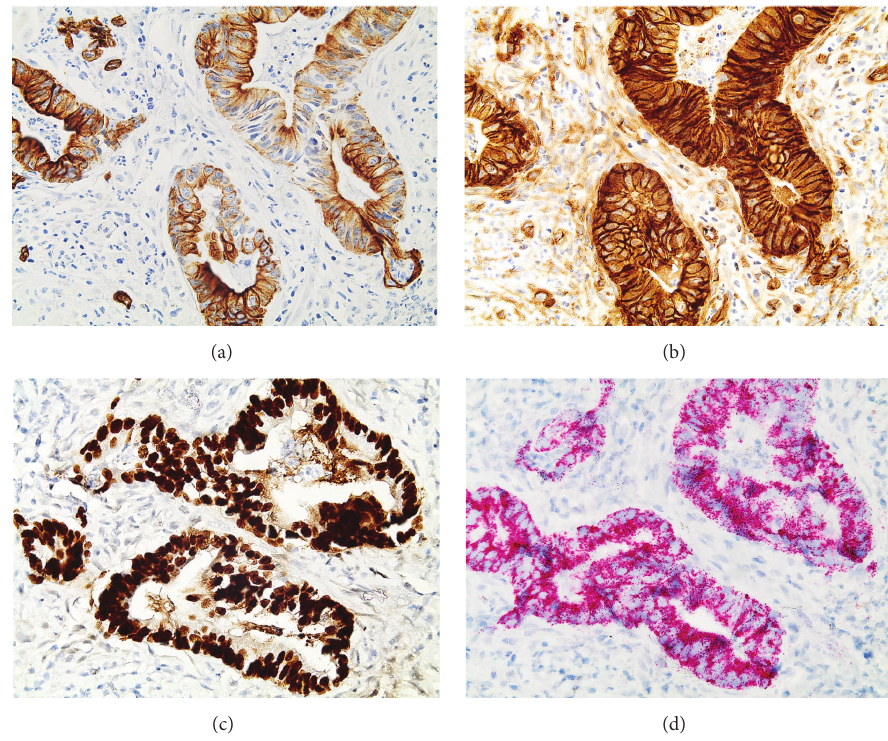
Figure 4: IHC of the biopsy showing positive expression of (a) CK7, (b) 𝛽 -catenin in a membranous/cytoplasmic staining pattern, (c) CDX2, and (d) AMACR ( ×